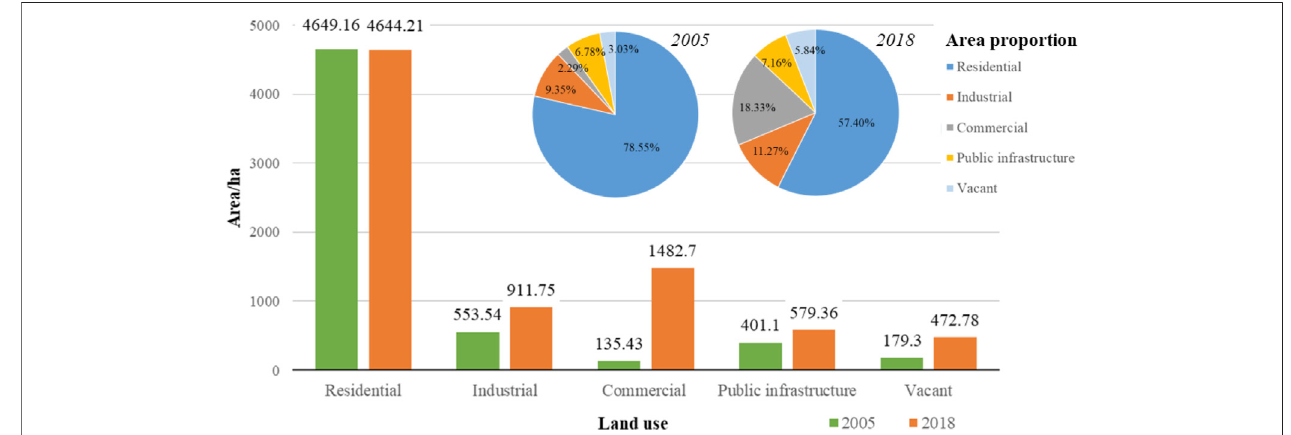
FIGURE 3 | Characteristics of internal land use change of rural communities from 2005 to 2018.